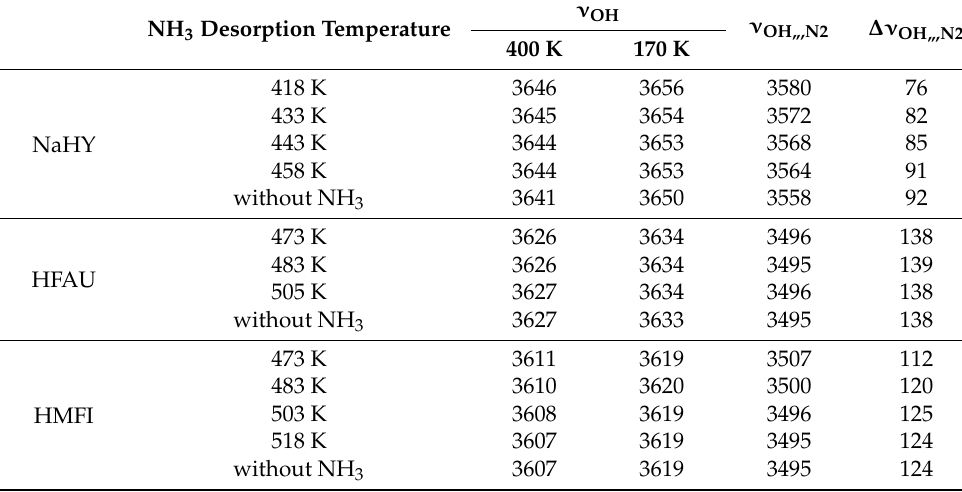
Table 1. The frequencies of IR bands of Si–OH–Al free and interacting with nitrogen in zeolites in which ammonia was sorbed and subsequently desorbed at various